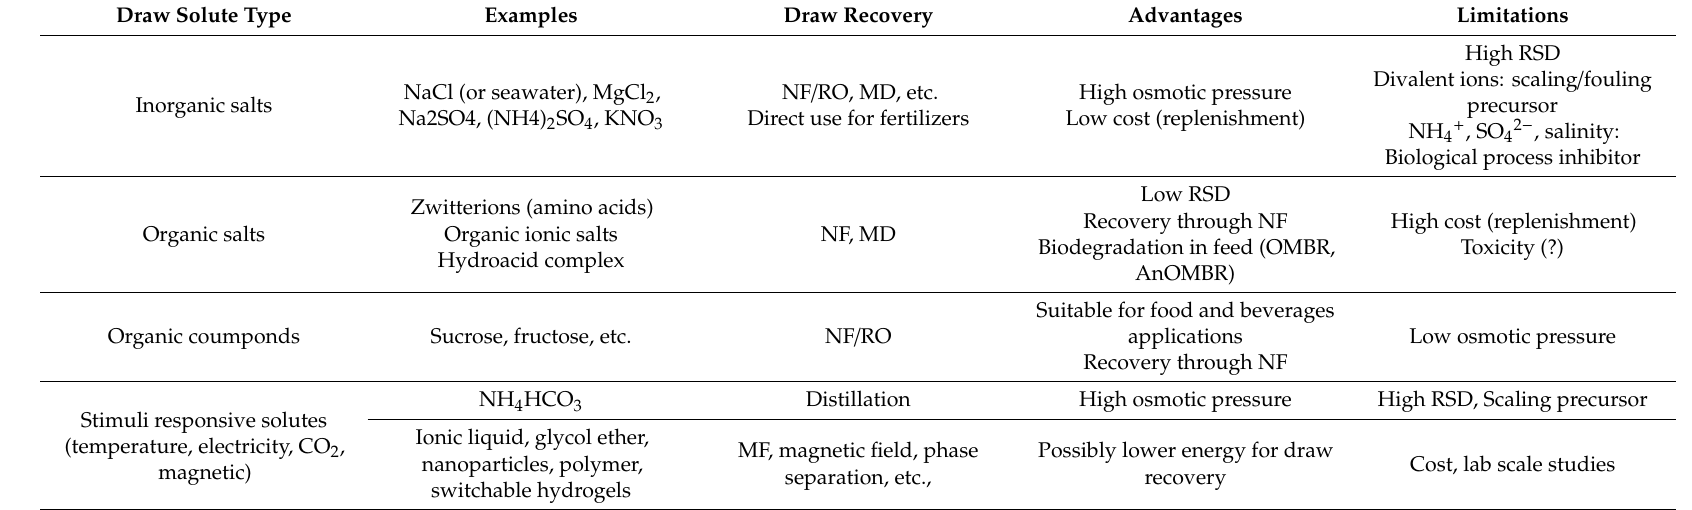
Table 6. Types of commonly available draw solutes and their corresponding pros and cons (adapted from